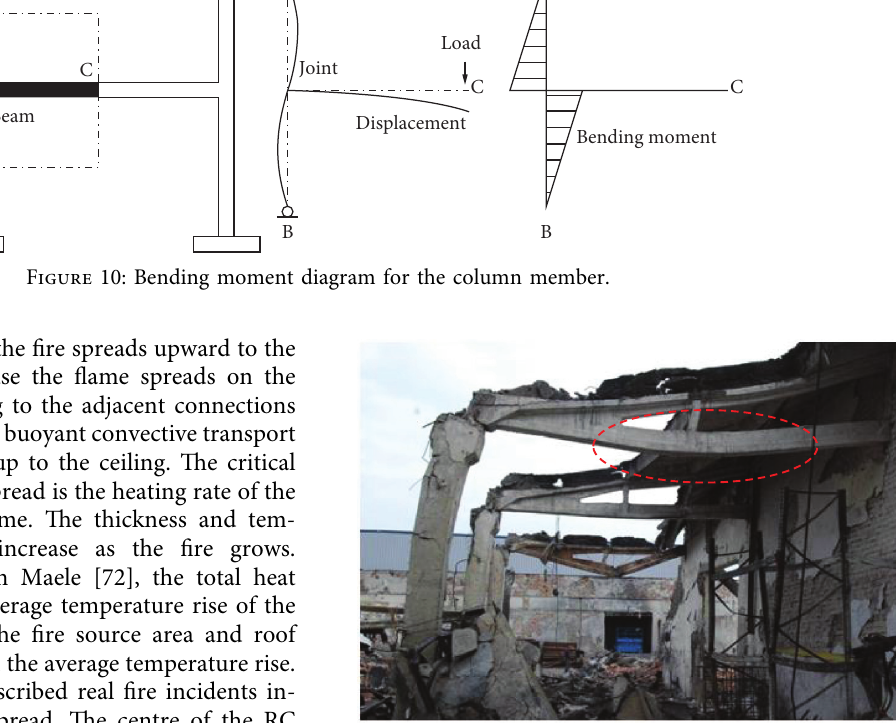
Figure 11: Deformation of the centre of the RC girders in a real fire incident